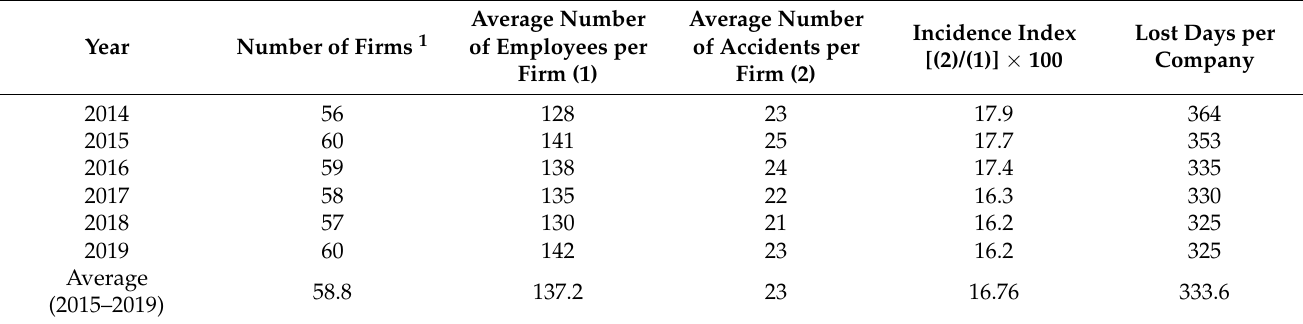
Table 5. Evolution of the magnitudes of incidence rates.